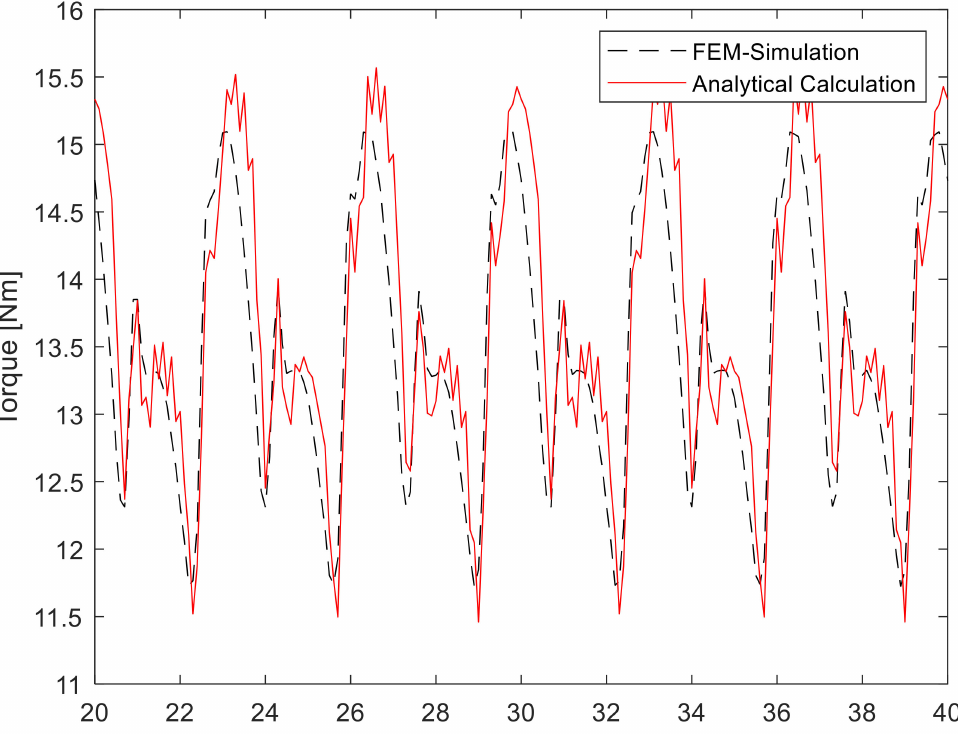
Figure 2. Torque curve of machine A.